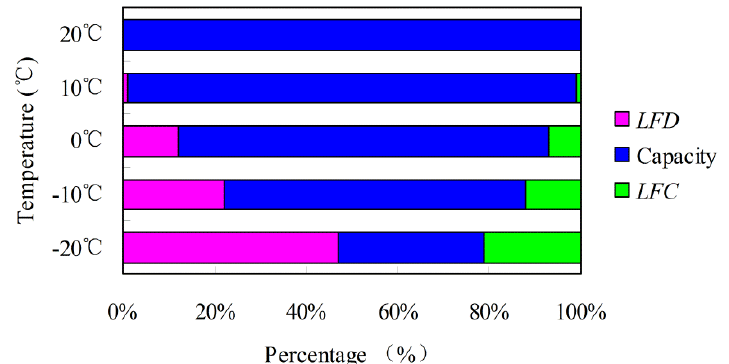
Figure 5. The percentage of LFD , LFC , and available capacity at different